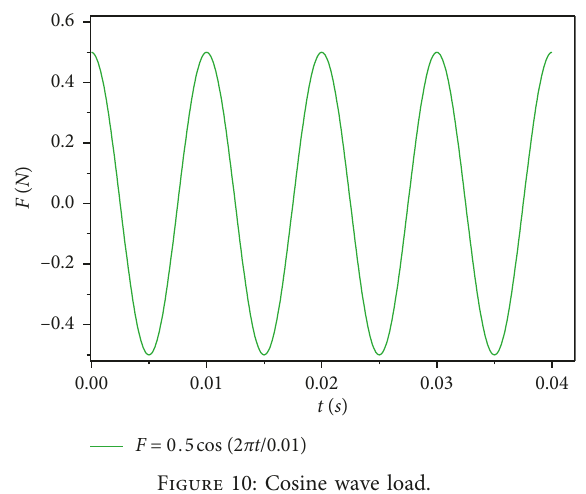
� − 5, − 1, 0, 1, and 5 of the FGPM